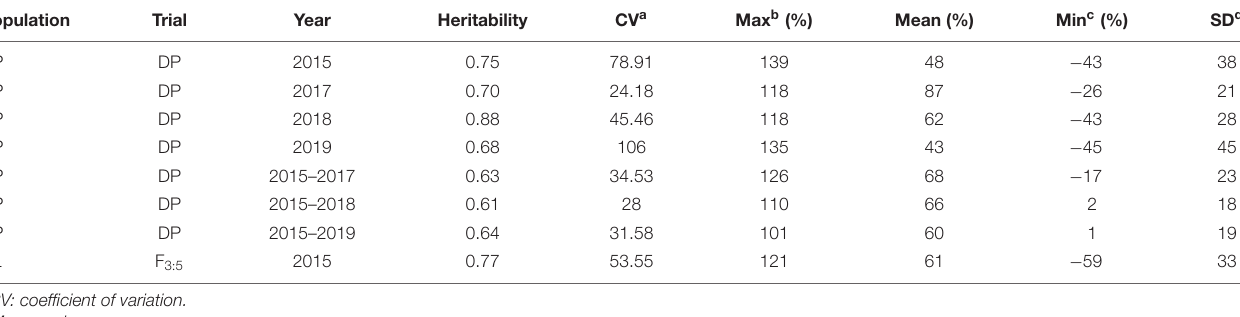
TABLE 2 | Cullis heritability and trial statistics for adjusted means for deep-sowing seedling emergence in individual and combined trials for the diversity panel (DP) population and breeding line (BL) population phenotyped from 2015 to 2019 and 2015, respectively. Population